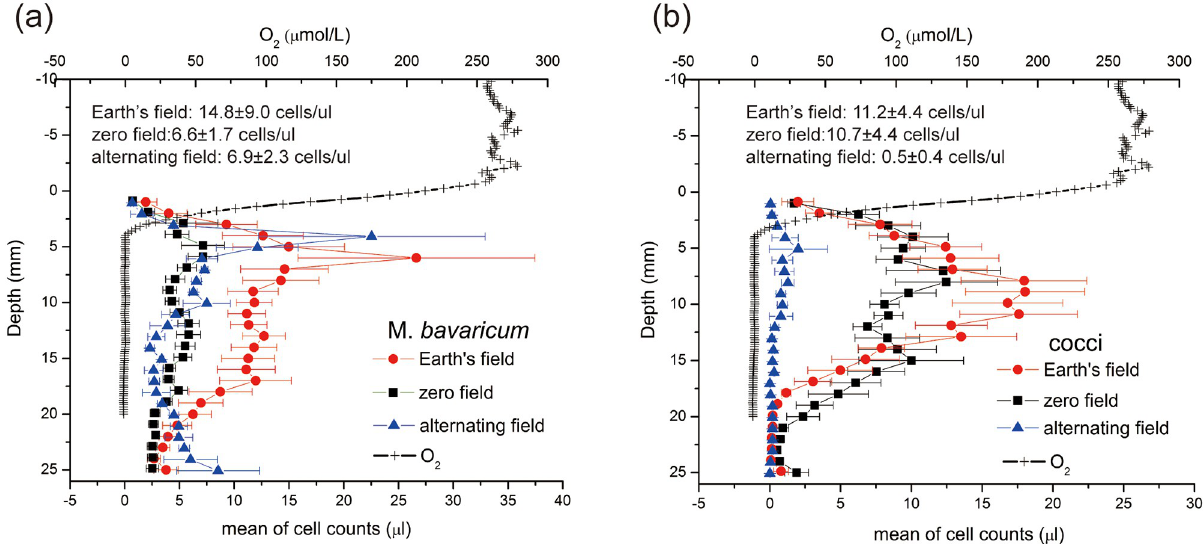
Fig 7. Vertical distributions in the three field settings. Vertical distributions (average of each field setting) of M . bavaricum (a) and cocci (b) in Earth’s field, zero field and alternating field. The population intensity (cells/ μ l) in three field settings was inserted.